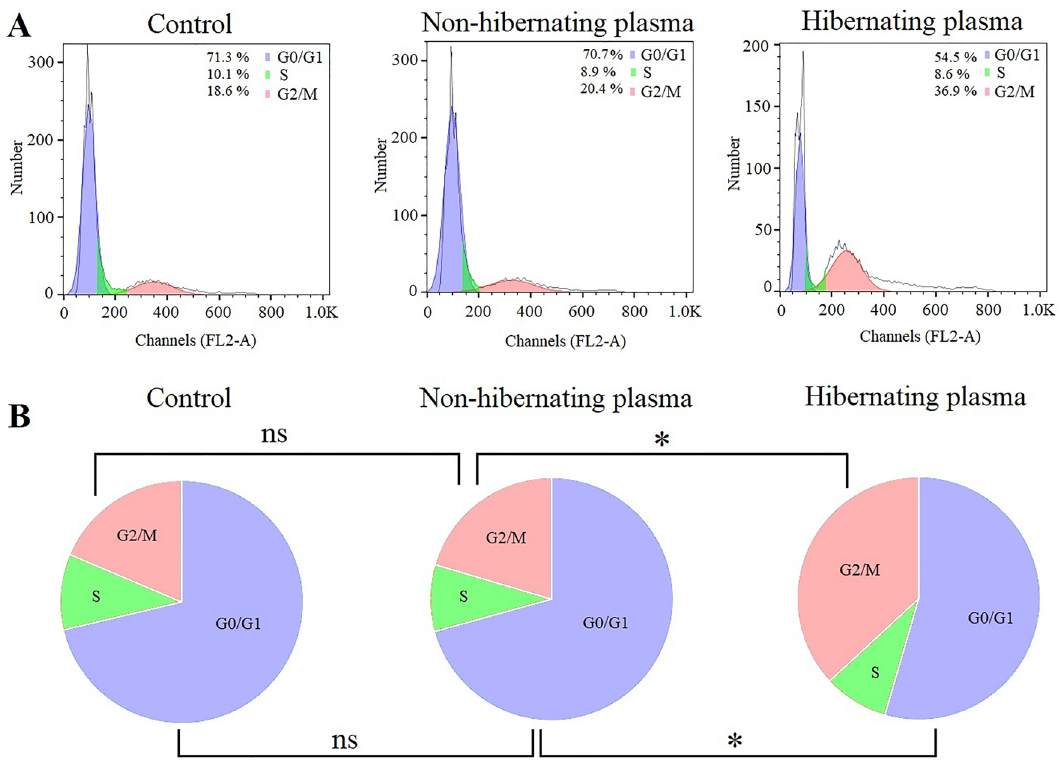
Figure 4. Evaluation of hibernating plasma effect on the cell cycle in cancer cells. ( A ) Representative flow cytometry cell cycle histogram of control, non-hibernating plasma (16 mg/ml, 24 h), and hibernating plasma (16 mg/ml, 24 h)-treated cells. ( B ) Pie charts of cancer cell distribution at different phases of the cell cycle in different groups. ( ns non-significant. *: P < 0.05).